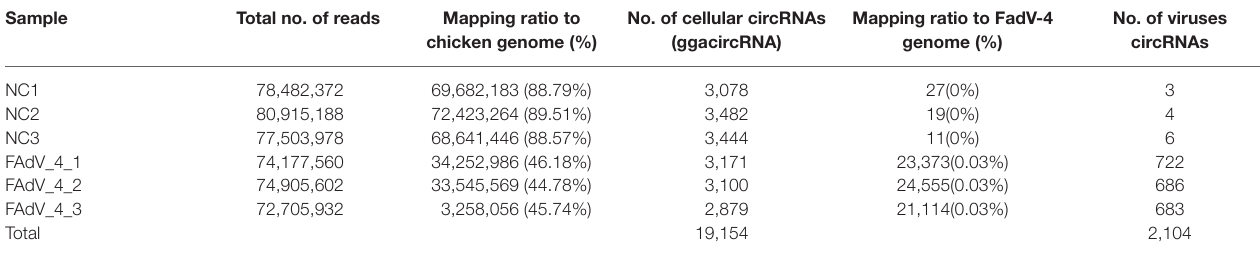
TABLE 1 | Summary of RNA-seq data sets from mock- and FadV-4-infected LMH cells.